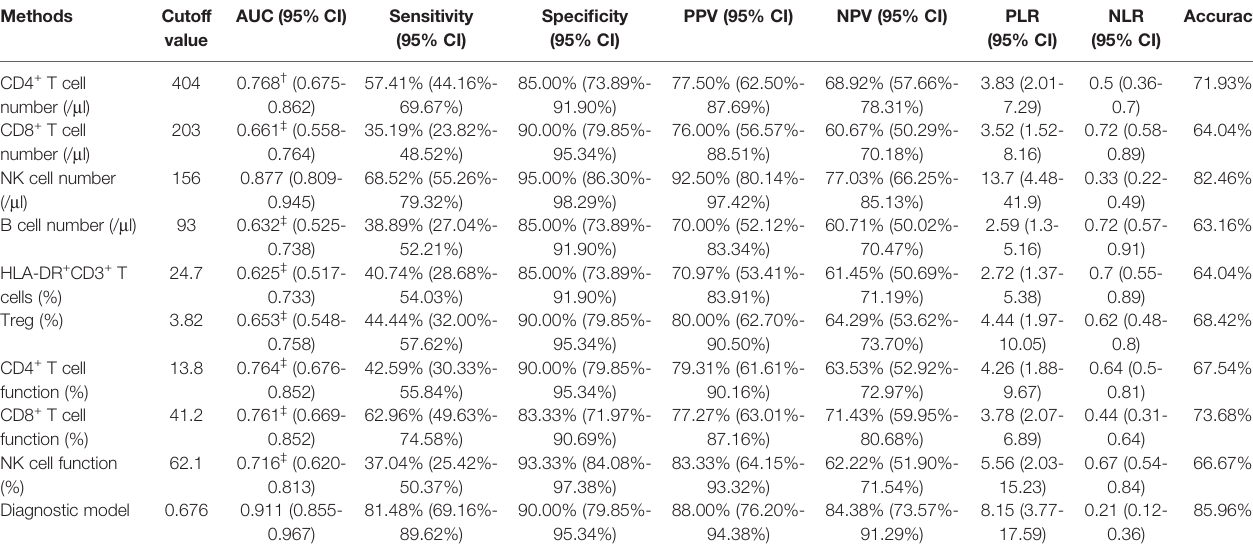
TABLE 3 | The performance of different methods for distinguishing between ATB and HC.